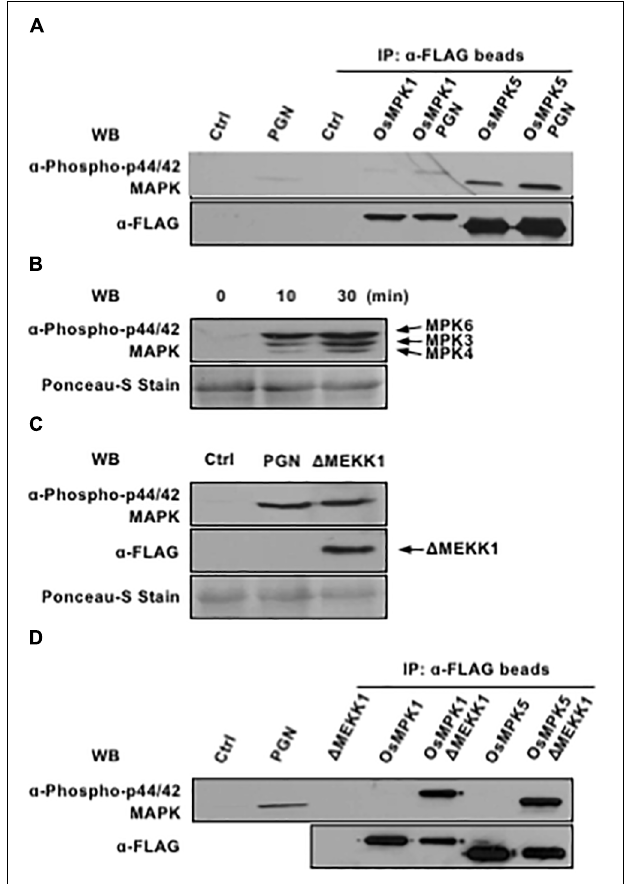
FIGURE 2 | OsMPK1 and OsMPK5 mediate PGN-induced MAPK activation in rice protoplasts. (A) OsMPK1 and OsMPK5 are activated by PGN in rice protoplasts. OsMPK1 or OsMPK5 were expressed in rice protoplasts overnight and immuno-precipitated with anti-FLAG-beads after 5 mg/ml PGN treatment for 10 min. MAPK activation (top) and MAPK expression (bottom) are shown. (B) PGN extracted from Xoo activates endogenous MAPK cascade in Arabidopsis protoplasts. Arabidopsis protoplasts were treated with 5 mg/ml PGN. MAPK activity (top) and loading control (bottom) are shown. (C) Constitutively active AtMEKK1 activates endogenous MAPK cascade in rice protoplasts. Rice protoplasts were transfected with construct expressing constitutively active MAPKKK of Arabidopsis . MAPK activation (top), MAPKKK expression (middle) and loading control (bottom) are shown. (D) Constitutively active AtMEKK1 activates OsMPK1 and OsMPK5 in rice protoplasts. OsMPK1 or OsMPK5 were co-expressed with constitutively active AtMEKK1 in rice protoplasts overnight, and then immuno-precipitated with anti-FLAG-beads. MAPK activation (top) and MAPK expression (bottom) are shown. The data shown here are representative of five independent